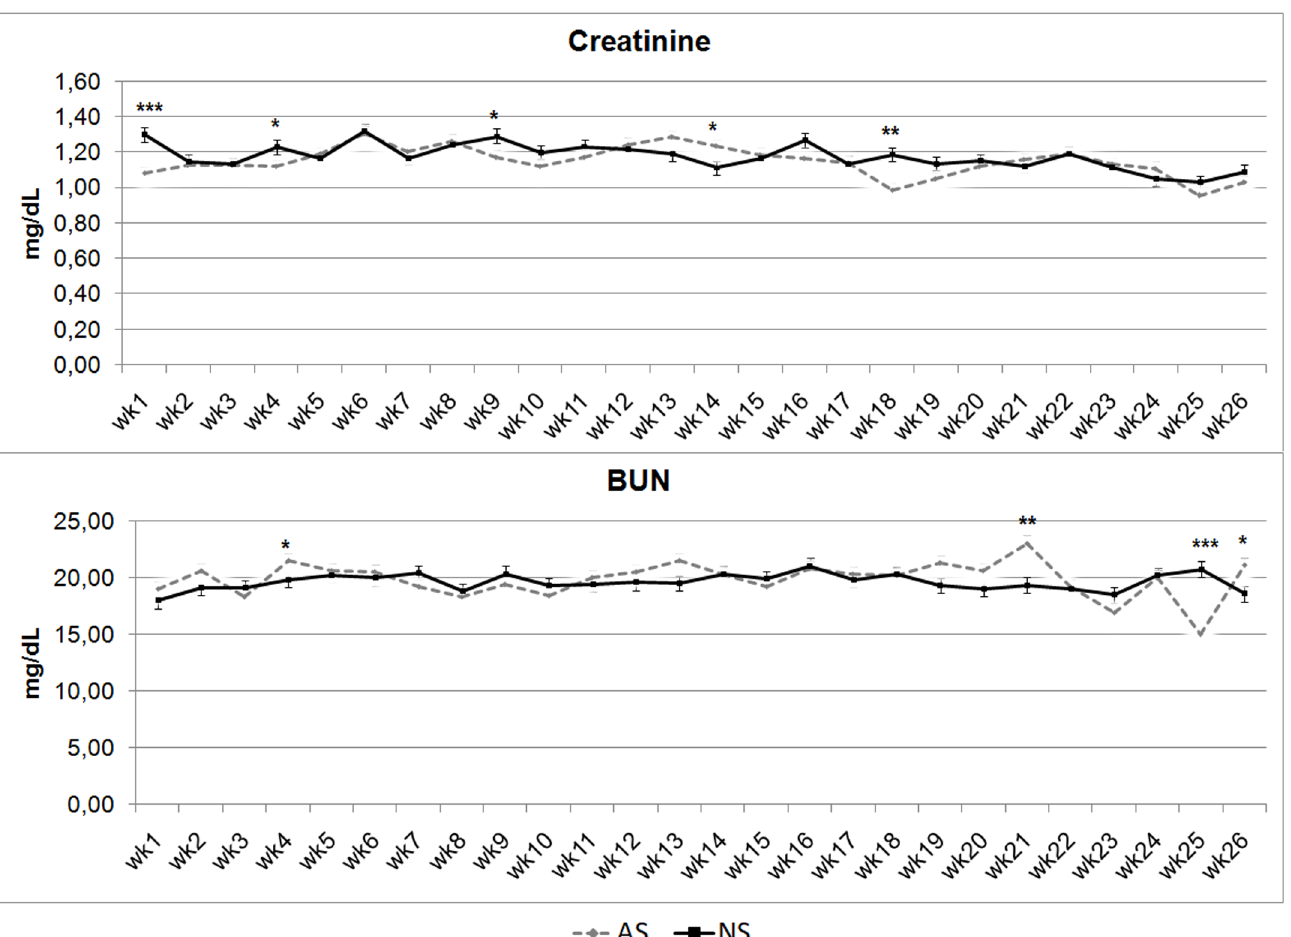
Fig 4. Creatinine and blood urea nitrogen (BUN) serum concentrations in artificially-suckled (AS) and naturally-suckled (NS) donkey foals during the first 26 weeks of life. (Values are Least Square Means; bars represents Standard Error of the Mean). Statistical differences between the two groups at the same week were expressed: (cid:3) = P < 0.05; (cid:3)(cid:3) = P < 0.01; (cid:3)(cid:3)(cid:3) = P < 0.001.